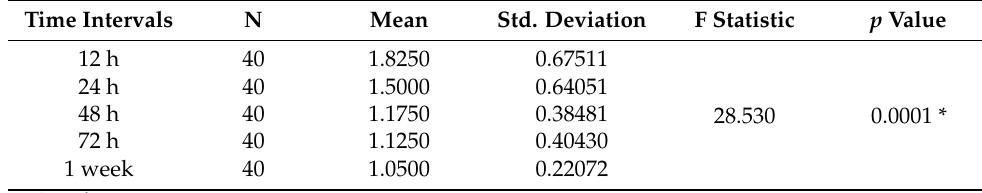
Table 7. VAS readings in Group 2 across time intervals.